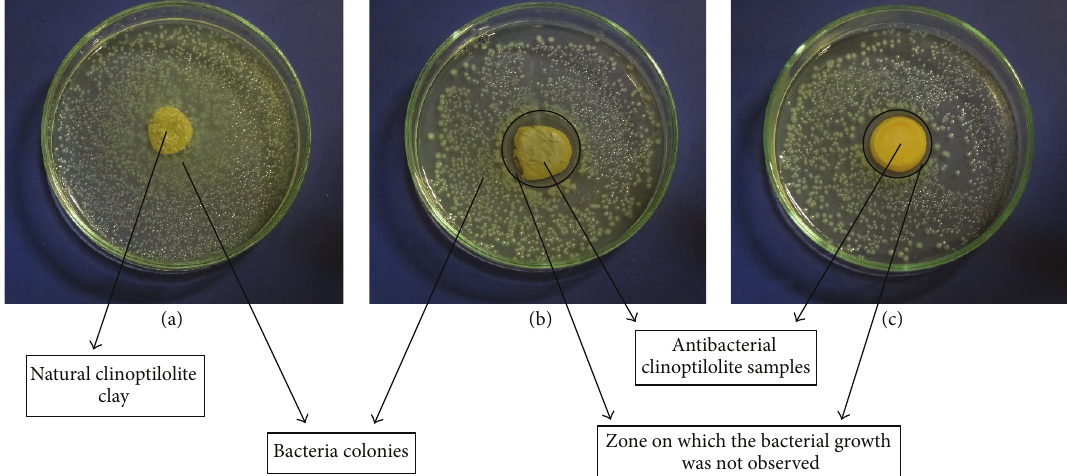
Figure 2: Antibacterial (modified halo) test results of the (a) neat, (b) physically treated, and (c) chemically treated